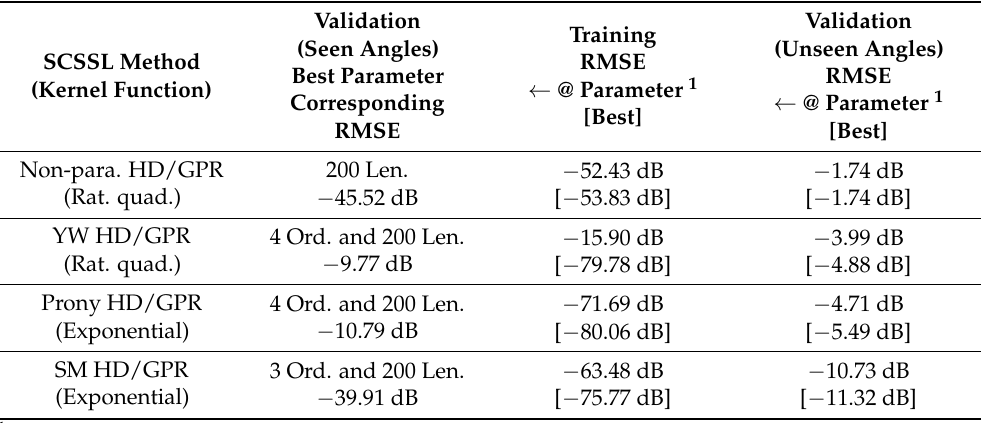
Table 3. The RMSE values for the selected kernel function and parameters.